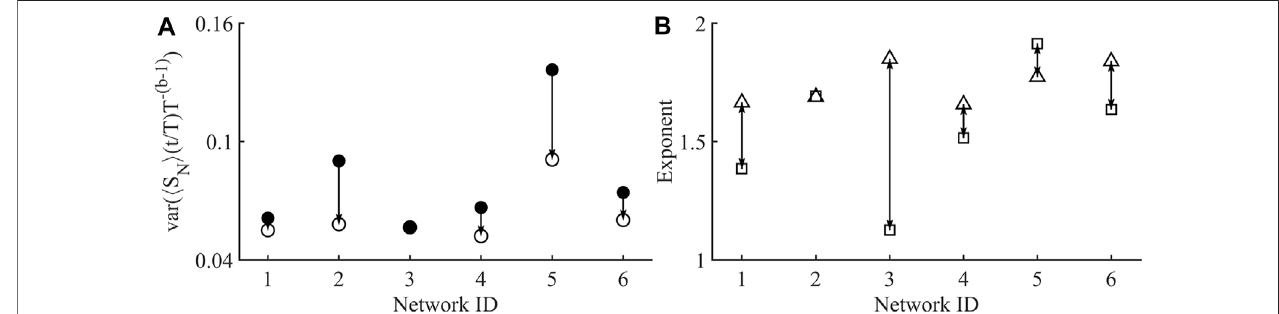
(cid:129) FIGURE 5 | (A) Plot showing the variance of the avalanche temporal pro fi les before ( ), and after collapse (o). Single arrow shows how the behaviour before collapse does actually tend to lower values after collapse which is to be expected in a critical system (Sethna et al., 2001). Network 3, shows a very small decrease in varianceaftercollapse,althoughitsstartingvarianceislowcomparedtotheothernetworks. (B) Plotshowingdistancebetweentheshapecollapseexponent (B) ( □ )and size givenduration exponent ( 1 σν z ) ( △ ).Double arrows highlight thecloseness inproximity thatexists inthese real-worldastrocyte networkswhichisexpected inan ideal critical system to be equal. Network 2, shows very close agreement between the two